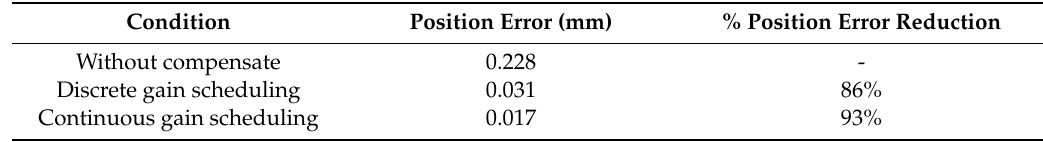
Table 6. Summary of the gain compensation by varying the linear